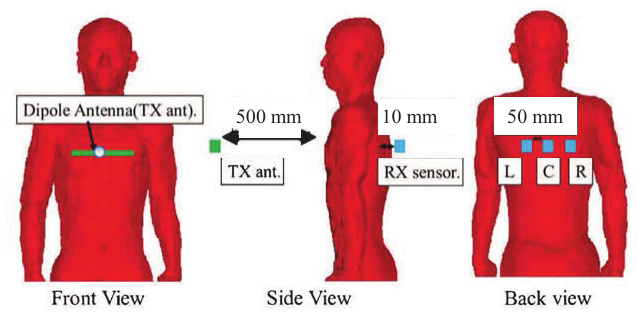
Figure 2. FDTD simulation environment. Tx ant: transmitting